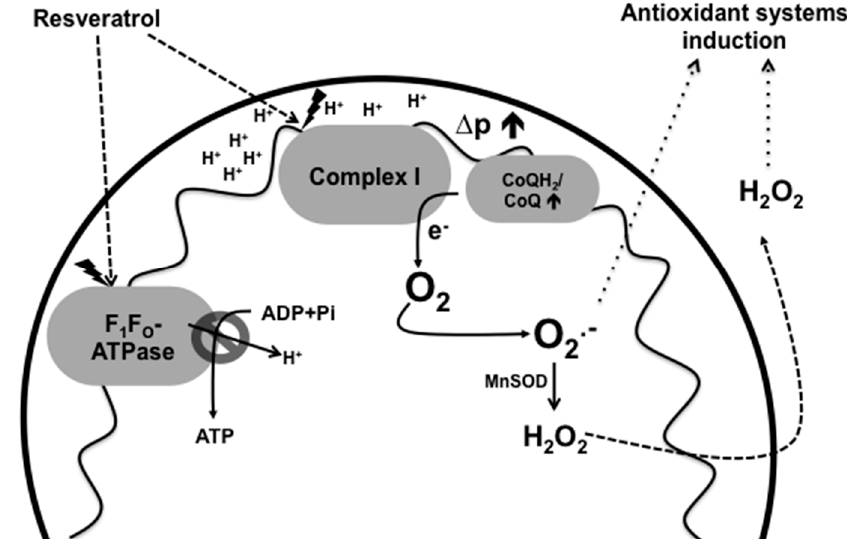
Figure 3. Pro-oxidant effects of resveratrol and its relation with the induction of antioxidant systems. The inhibition of complex I and/or F 1 F 0 -ATPase by RSV causes disengagement of the ETC with an increase in mitochondrial membrane potential ( ∆ p ) and production of O 2 − and H 2 O 2 , as well as a decrease in ATP production and breathing. Increased ROS production could subsequently induce the antioxidant response as a defense mechanism.